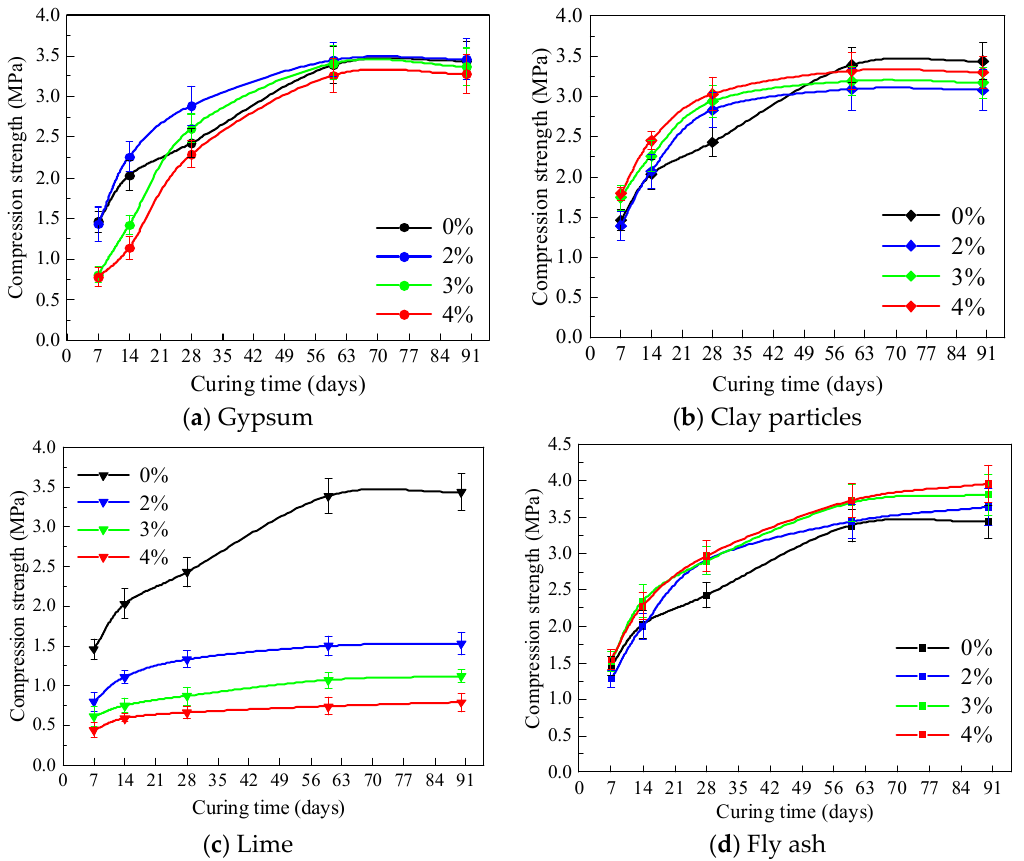
Figure 4. Curve of unconfined compressive strength with different replacement ratios of the additives.